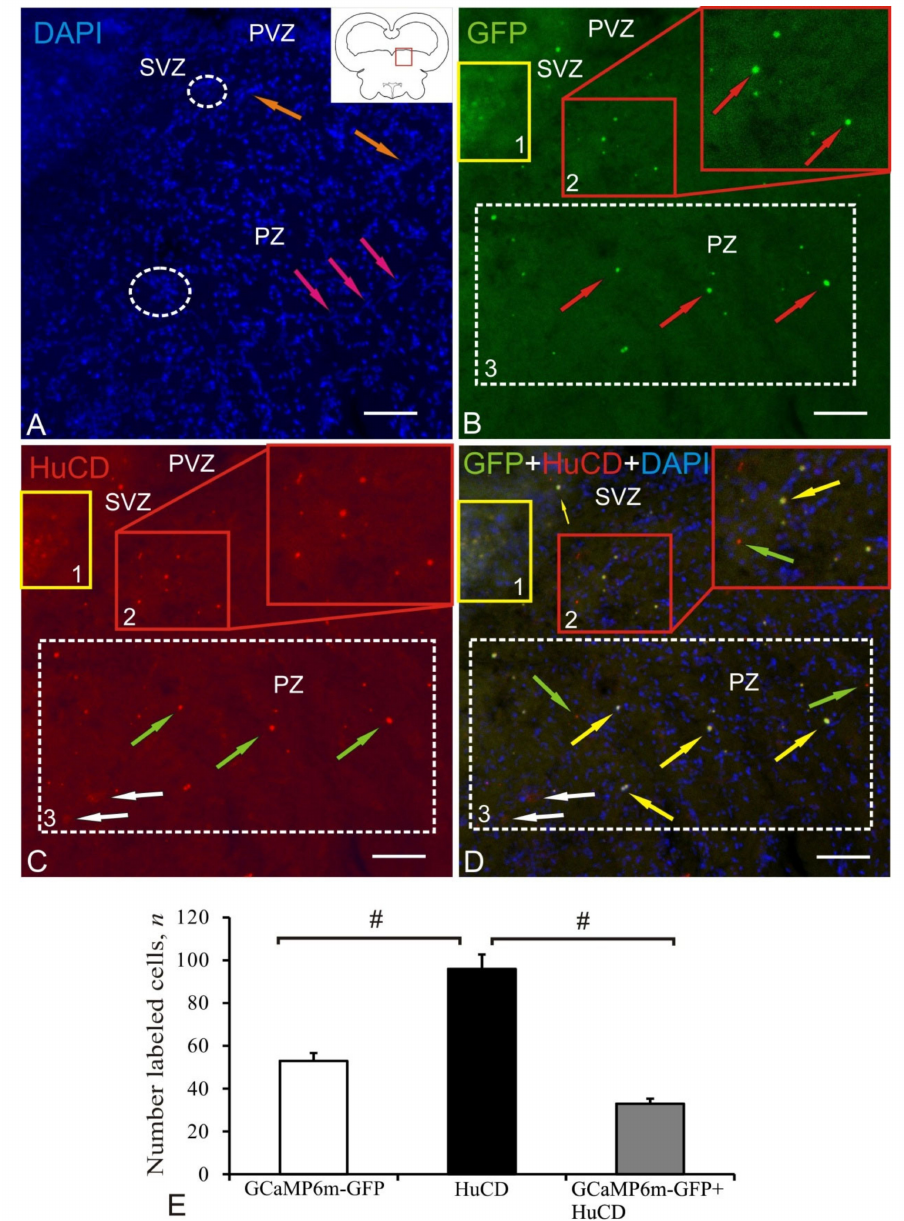
Figure 5. Z-stacks representing HuCD immunolabeling in the dorso-medial tegmentum of juvenile chum salmon, O. keta , 1 week after a single injection of recombinant AAV into the mesencephalic tegmentum area. ( A ) DAPI staining, the pictogram shows the area of the dorso-medial tegmentum (outlined by red rectangle, resting nuclei are indicated by orange arrows, migrating ones by pink arrows), clusters of nuclei are outlined by the white dashed oval, PZ is the parenchymal zone, and the other designations are as in Figure 4A. ( B ) GFP expression in cells (red arrows) of population № 1 (outlined by the yellow rectangle), population № 2 (outlined by the red rectangle, greater magnification in the inset), and population № 3 (outlined by the white dashed rectangle). ( C ) Immunofluorescence of HuCD (populations № 1–3) in small intensely labeled cells (green arrows) and large weakly labeled cells (white arrows). ( D ) Superposition of three DAPI/GFP/HuCD staining channels, showing areas of GFP/HuCD colocalization in neurons of populations № 2 and 3 (yellow arrows), cells without marker colocalization (green arrows), in populations № 3 large weakly HuCD-labeled cells (white arrows). Laser scanning confocal microscopy. Scale bar: 200 µ m. ( E ) Results of ANOVA analysis showing the comparative distribution of labeled cells and nuclei (M ± SD, where M is the mean and SD is the standard deviation) of the dorso-medial tegmentum of chum salmon. Significant intergroup differences (# < 0.05) were found between the groups of GCaMP6m-GFP+ and HuCD+ cells and the groups of HuCD+ and GCaMP6m-GFP+/HuCD+ cells ( n = 5 in each